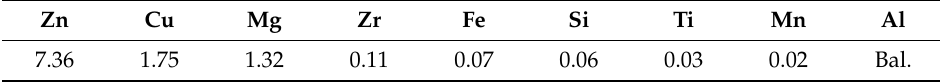
Table 1. Components of 7085 aluminum alloy (mass fraction /